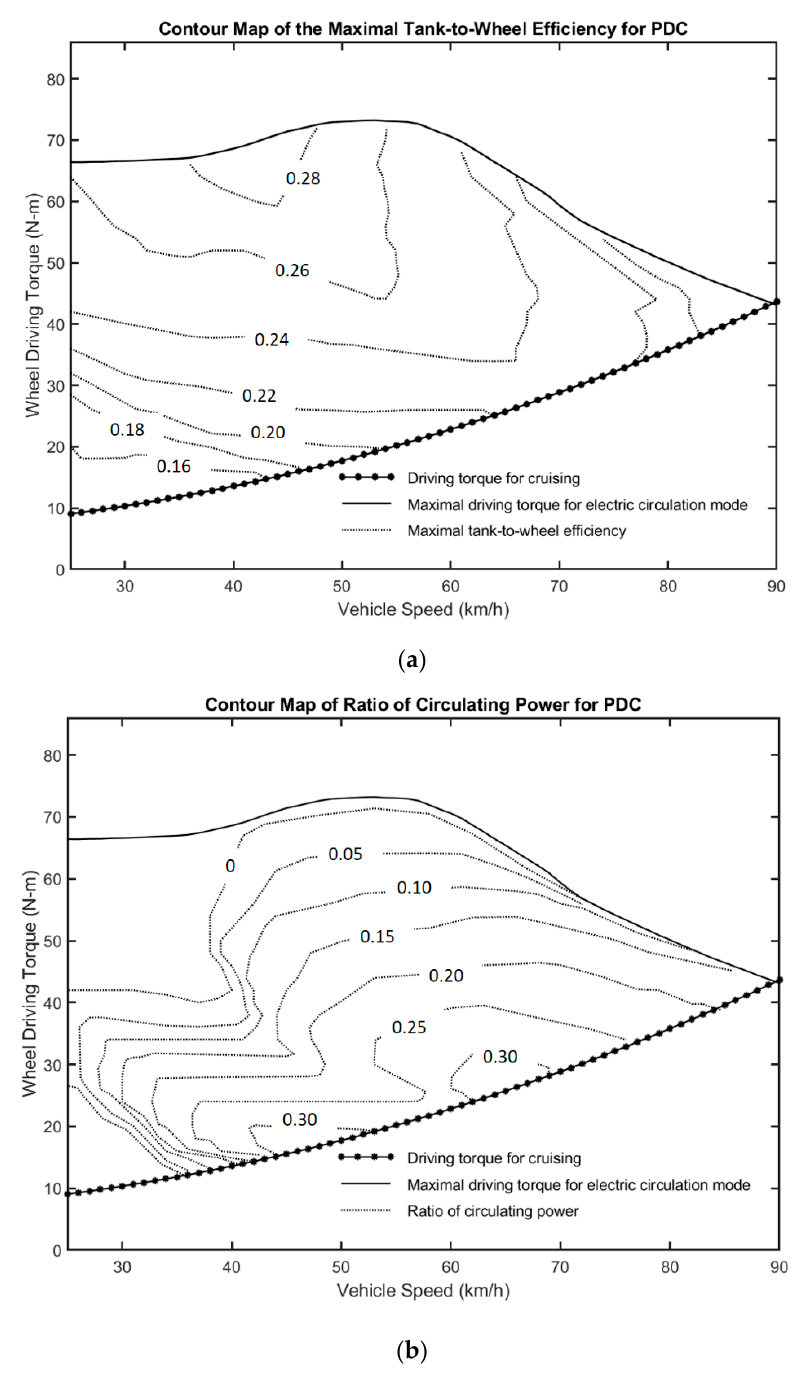
Figure 11. Contour maps of ( a ) maximal η tw and ( b ) ζ vs. vehicle speed and wheel driving torque for PDC [20].